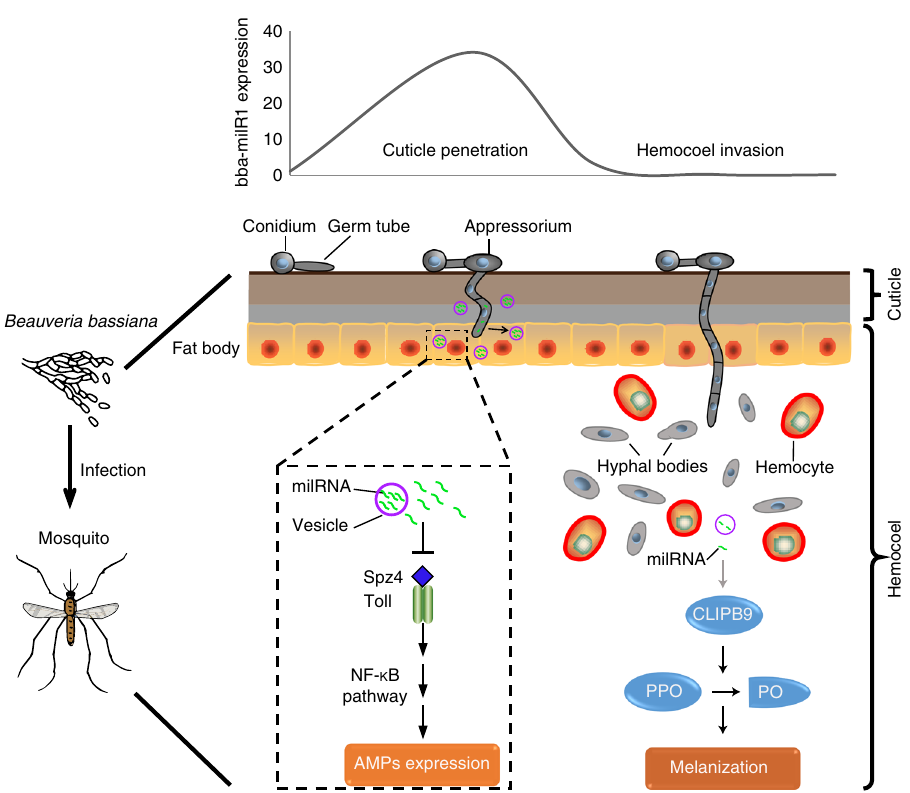
Fig. 6 Model of Beauveria bassiana deploying bba-milR1 to modulate mosquito immunity. During early stages of infection, B. bassiana bba-milR1 is highly expressed, and translocated into the mosquito cells to attenuate mosquito immune responses by suppressing the expression of the key activator gene Spz4 . At this early stage in the integument, the bba-milR1 is not accessible to circulating hemocytes, the site of CLIPB9 gene expression. During later infection stages when the fungus enters the hemocoel, B. bassiana markedly decreases the expression of bba-milR1 to elaborately avoid induction of CLIPB9 and activation of melanization via conversion of prophenoloxidase (PPO) to phenoloxidase (PO) (see Fig.